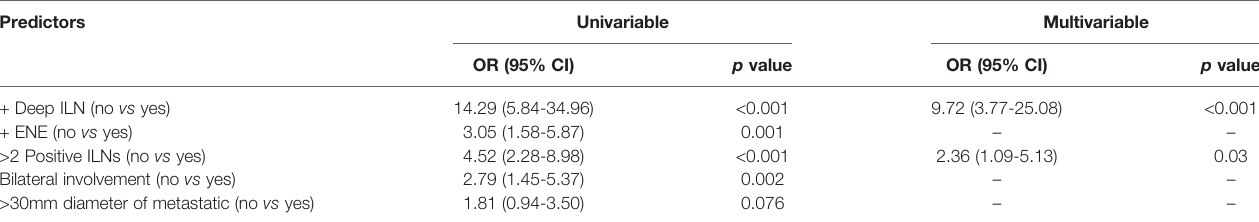
TABLE 2 | Univariable and multivariable logistic regression analysis predicting PLNM by inguinal lymph node characteristics.